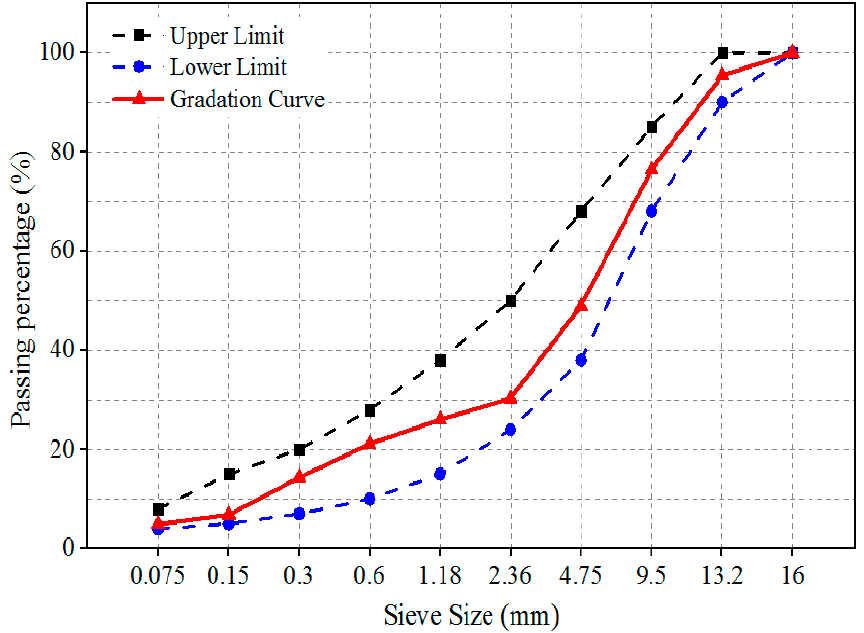
Figure 2. Aggregate (limestone) gradation curve for the AC-13 asphalt mixture.